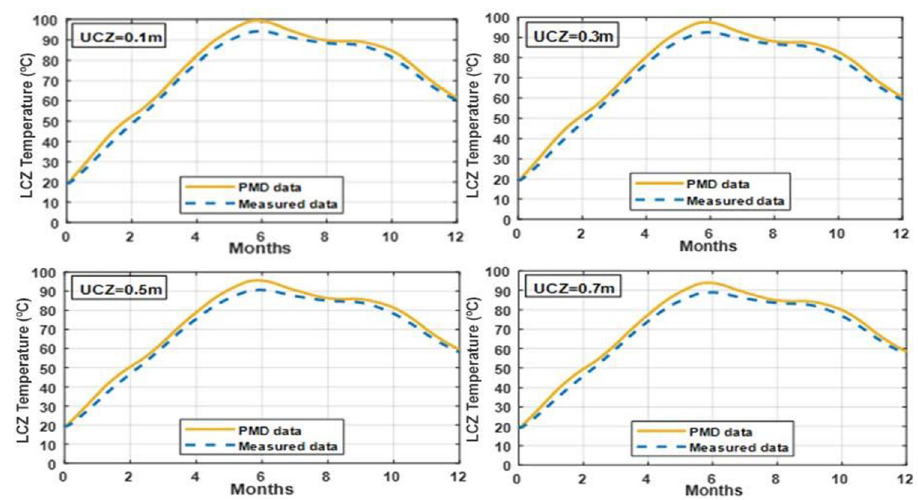
Fig 11. Effect of different thickness of UCZ on the temperature of LCZ with NCZ = 1 m and LCZ = 0.7 m under PMD and measured climatic conditions of Lahore.